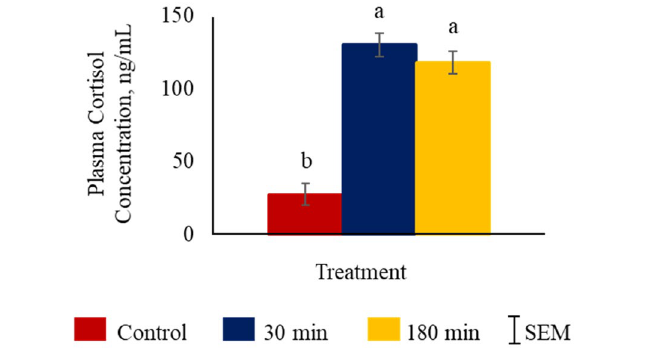
Figure 1. Effects of stress treatment (Control = not transported but held in pens; 30 min = transported for 30 min; 180 min = transported for 180 min) on mean ± SEM plasma cortisol concentrations in